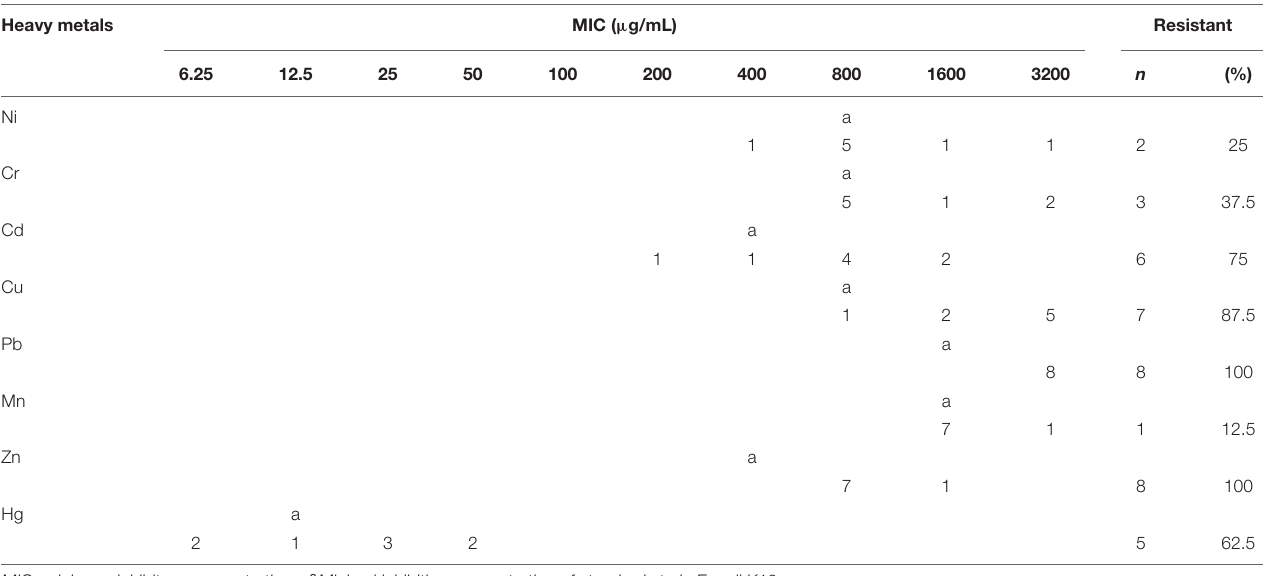
TABLE 3 | Heavy metal resistance of V. parahaemolyticus isolates.